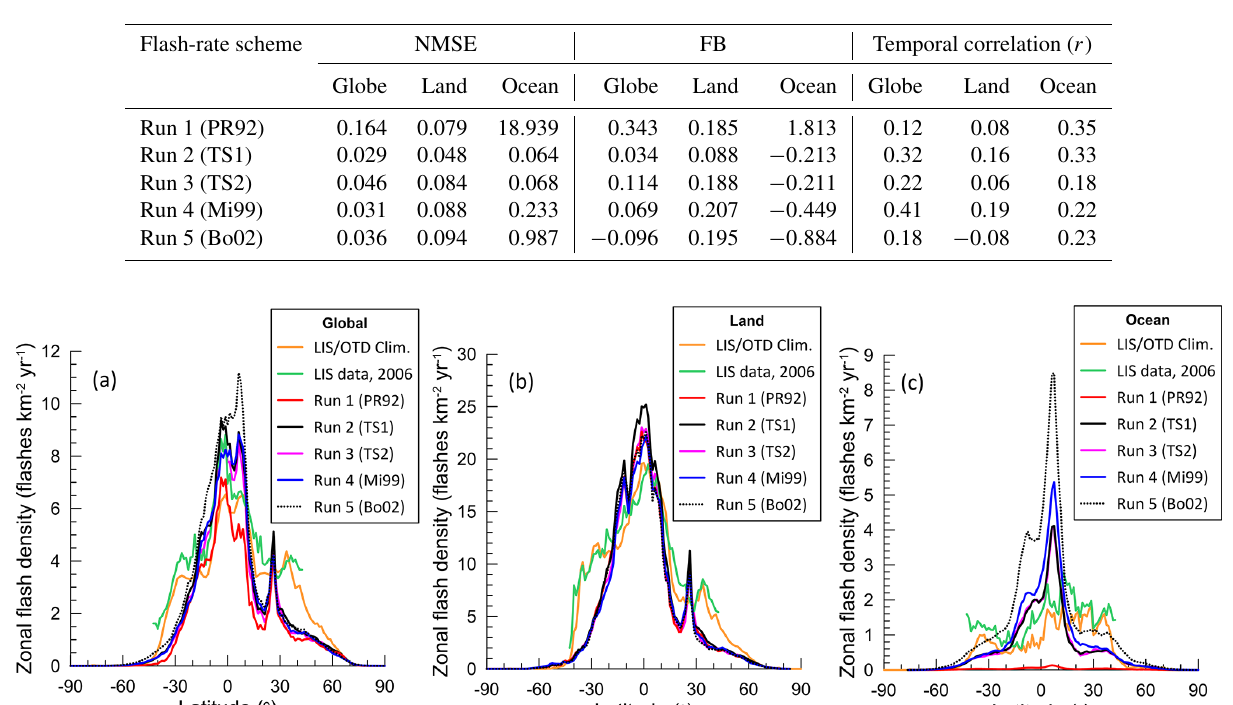
Table 2. Normalised mean square error (NMSE), fractional bias (FB), and correlation coefficient ( r ) for the monthly varying observed climatology and modelled flash rates shown in Fig. 3.